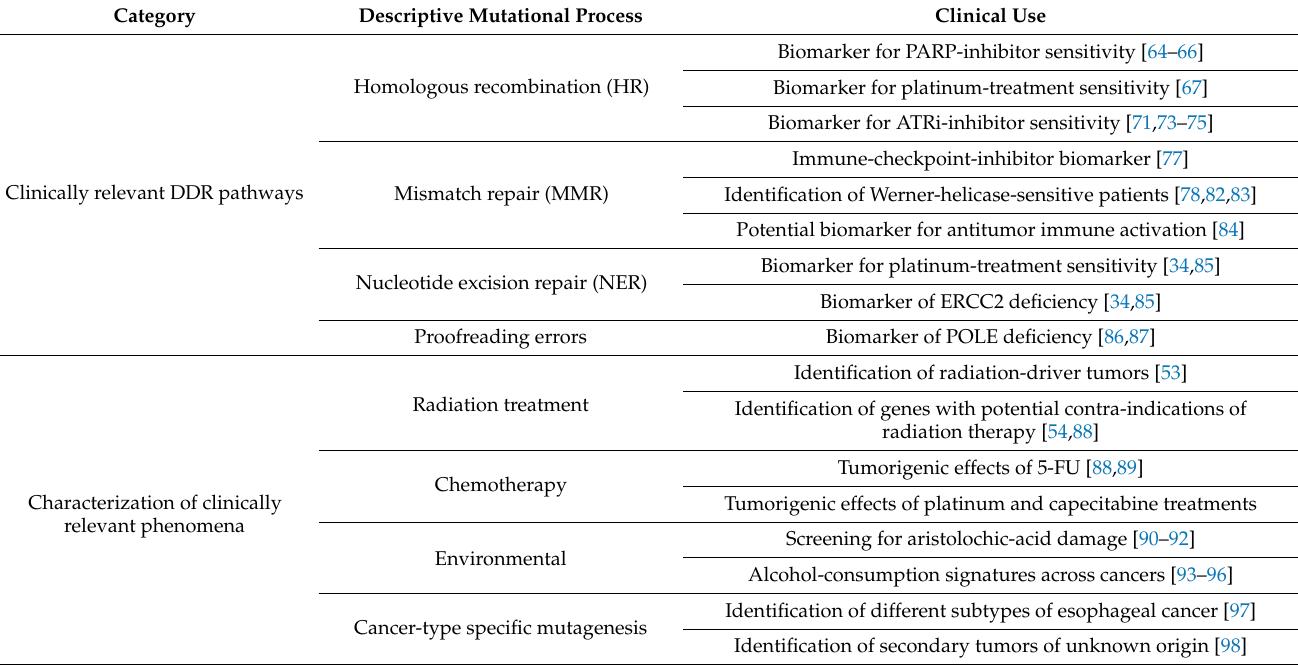
Table 1. Clinical applications of mutation